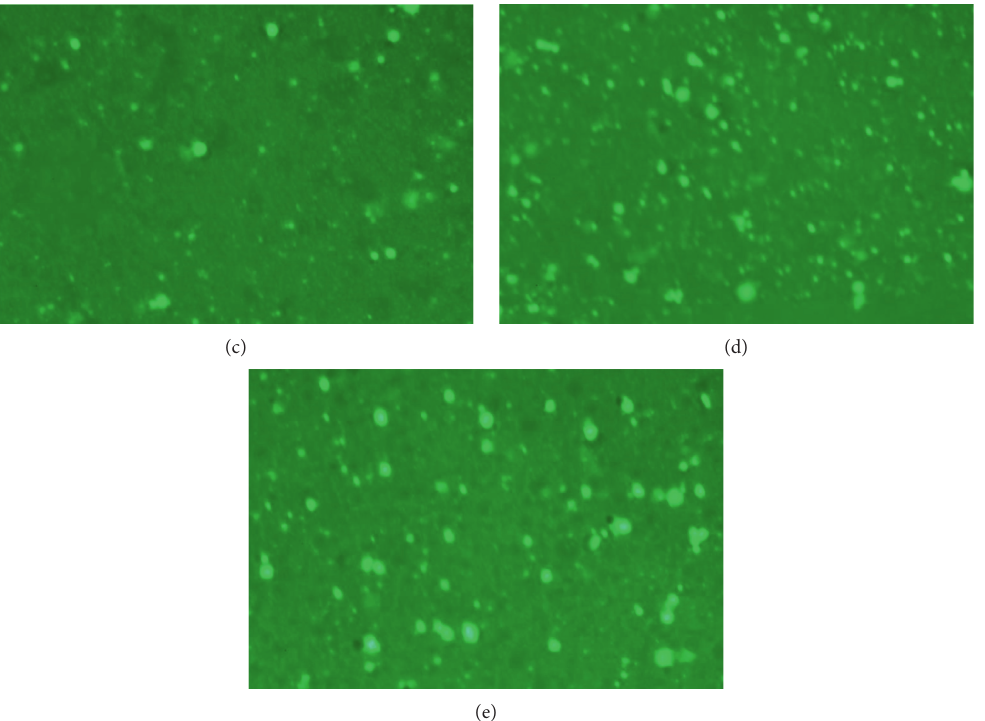
Figure 9: Fluorescence micrographs of SBS-LMAE samples with different SBS concentrations: (a) 0%, (b) 1.5%, (c) 3.0%, (d) 4.5%, and (e) 6.0% (magnification: ×